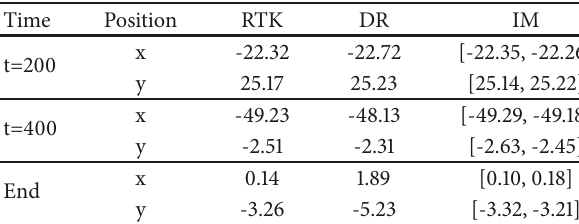
localization result. The width of the interval error corridors (see Figure 17) with respect to the vehicle’s 𝑥 position and 𝑦 position is displayed in Figure 19, reporting a maximum value of 0.6 m. The average interval error width and mean RSSE are computed to evaluate the localization accuracy. Table 3 details the results of the 3 experiments. Computing an average value for the 3 experiments gives 12.7 cm accuracy for 𝑥